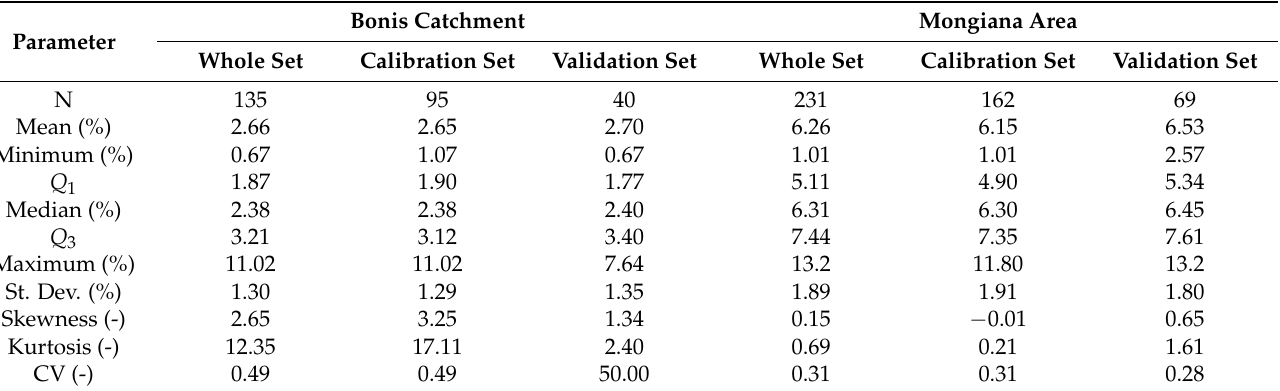
Table 1. Summary statistics of soil organic carbon (SOC) at the two study areas of the whole sets of data and calibration and validation